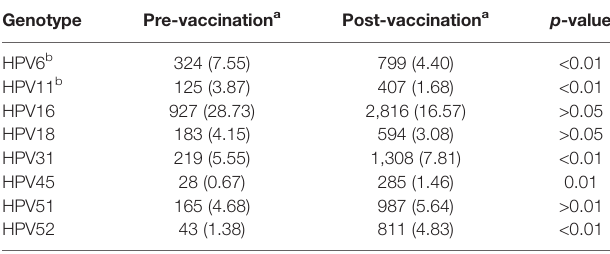
TABLE 1 | Averages of the main human papillomavirus (HPV) genotypes in the pre- and post-vaccination periods.